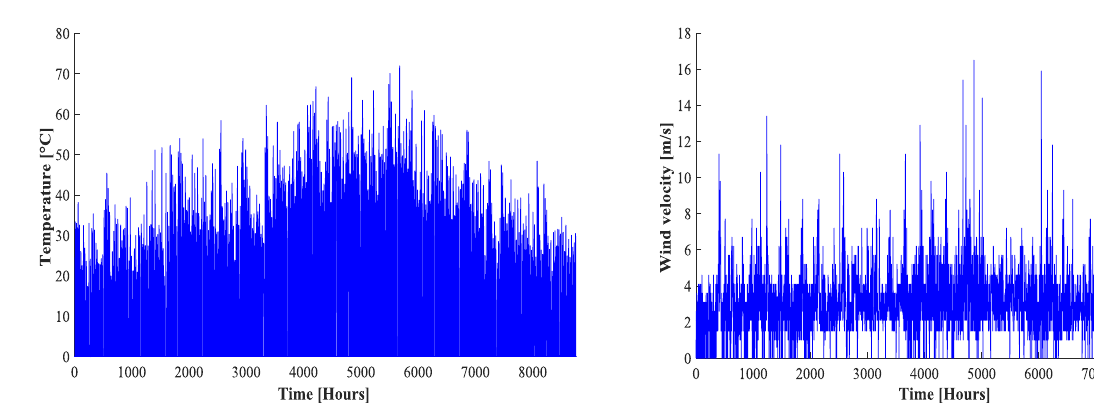
Fig. 14 Annual database of the wind velocity